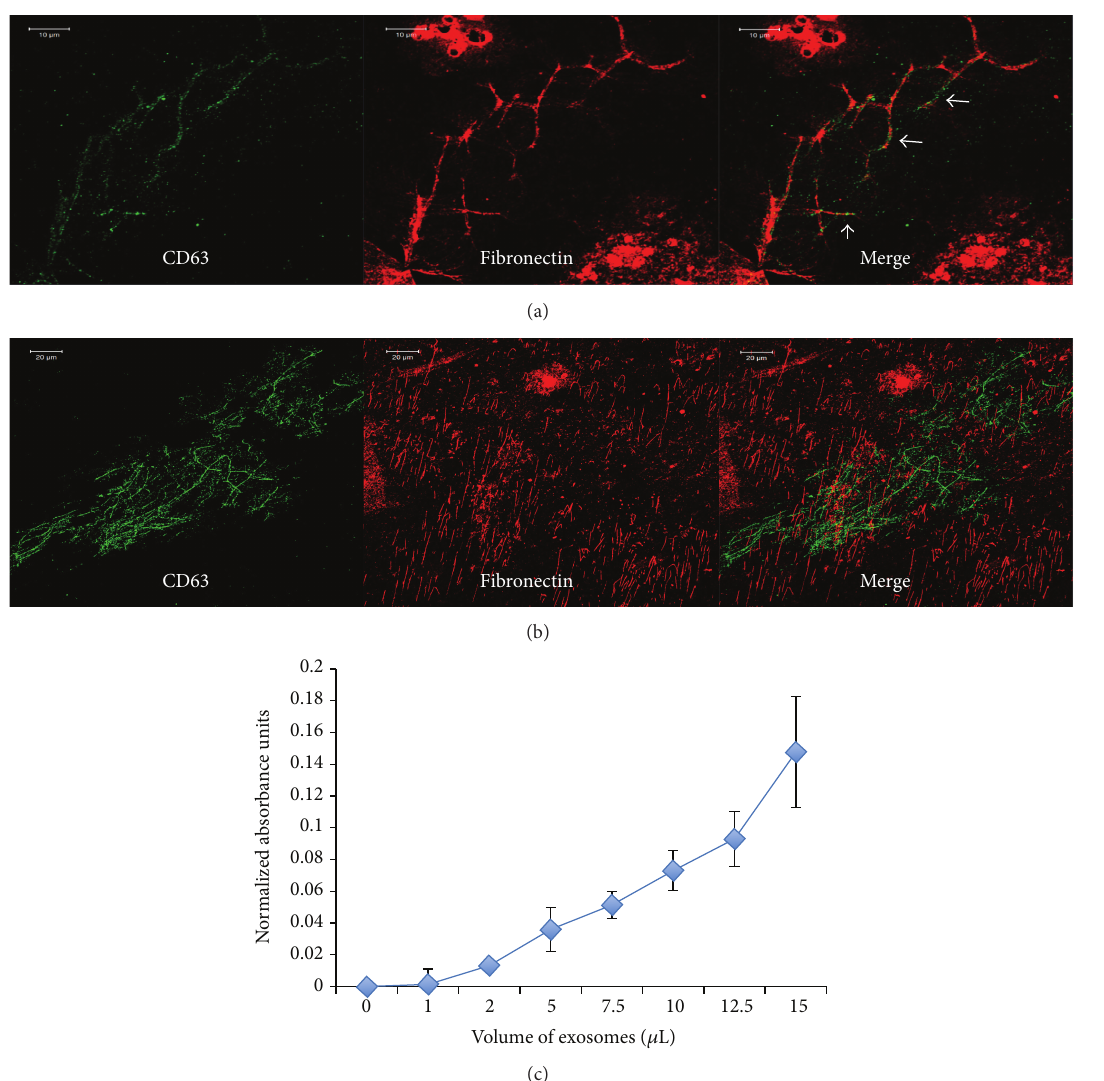
Figure 3: Binding of exosomes to ECM proteins: (a) confocal micrograph showing colocalization of exosomes (immunolabeled with CD63 antibody in green) with fibronectin (immunolabeled in red) present in the ECM of HMSCs. Arrows point to areas of colocalization. Scale bar represents 10 𝜇 m. (b) Confocal micrograph showing exosomes immunolabeled with CD63 antibody bound to the ECM of HMSCs. Note the fibrillar pattern of binding indicating binding to an ECM structural protein. However, no colocalization was observed with fibronectin (immunolabeled in red) indicating the ability of the exosomes to bind multiple ECM proteins. Scale bar represents 20 𝜇 m. (c) Graphical representation of dose dependent exosomal binding to type I